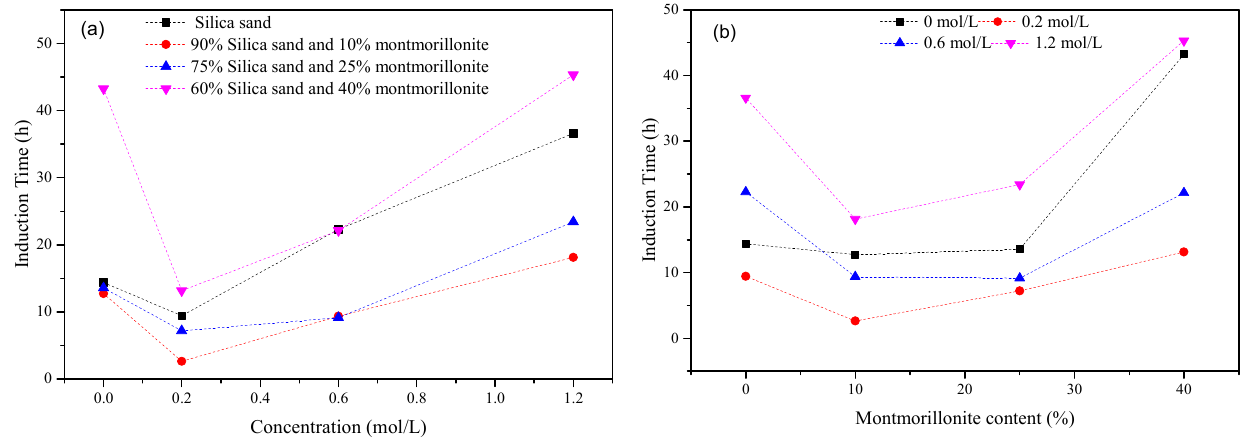
Figure 5. Comparison of induction time. ( a ) Induction time under different NaCl concentrations. ( b ) Induction time under different montmorillonite contents.